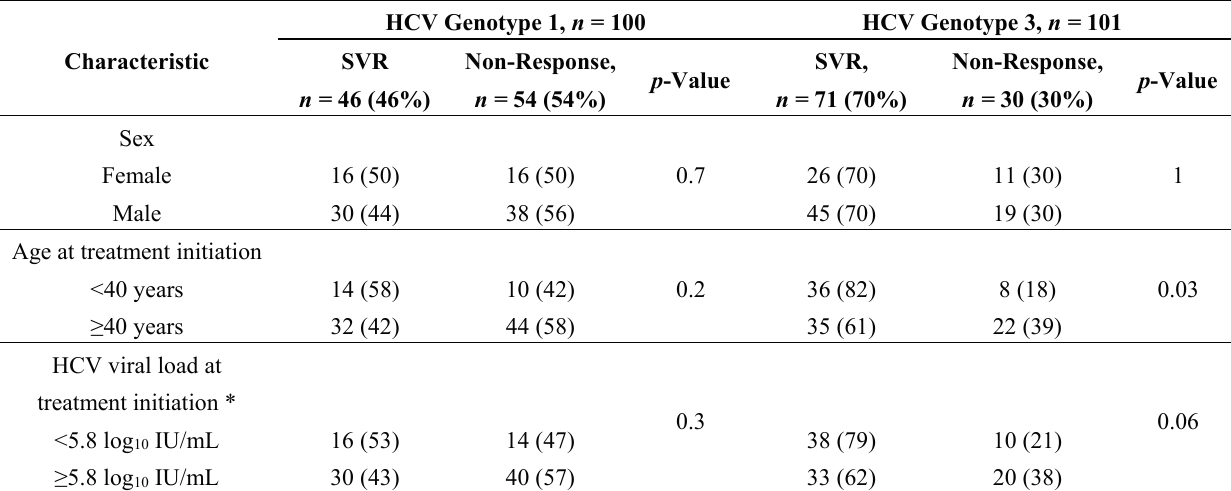
Table 2. Comparison of sustained virological treatment response rates in 201 individuals with chronic hepatitis C virus